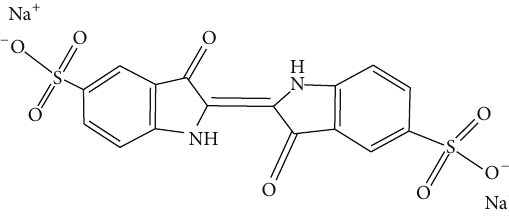
Figure 1: Molecular structure of indigo